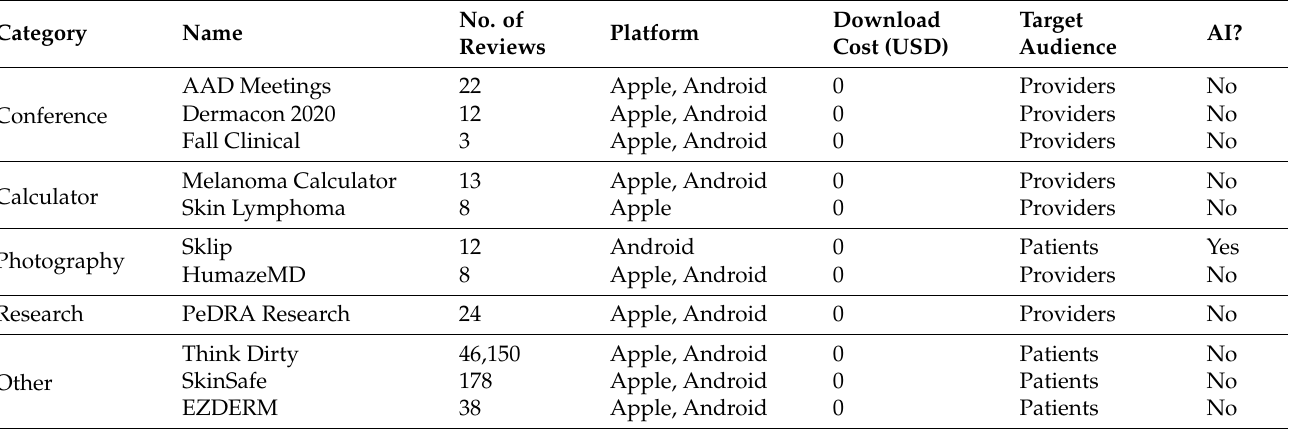
Table 2. Characteristics of the top apps per category based on number of reviews for categories with less than 50